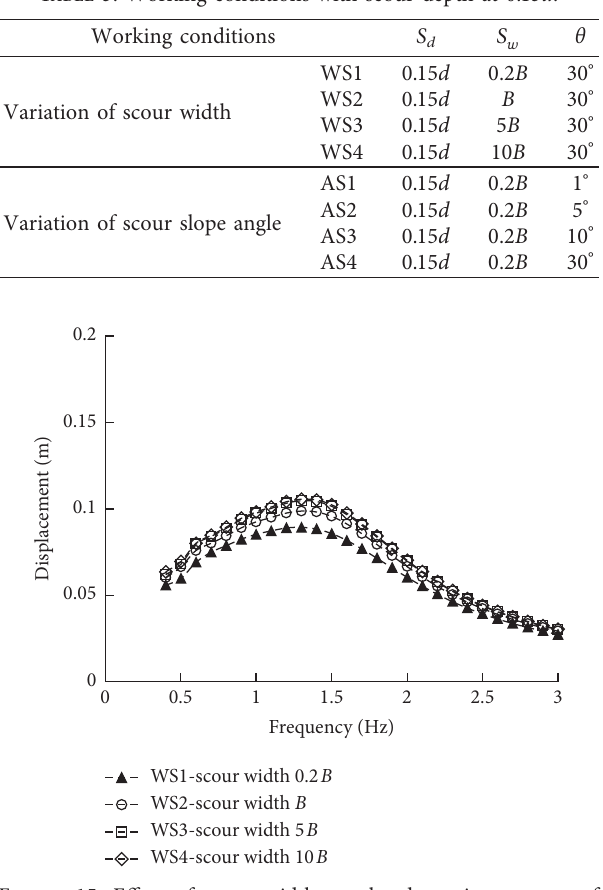
Figure 15: Effect of scour width on the dynamic response of caisson foundation ( S d � 0.15 d